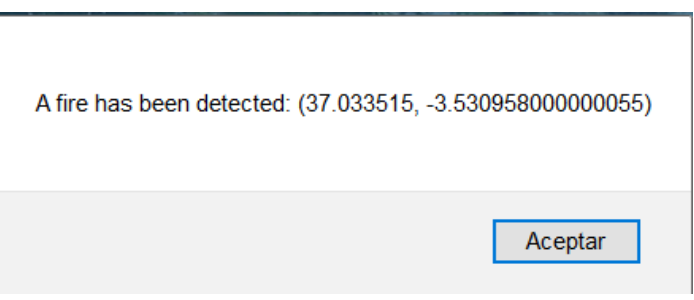
Figure 14. The Pop-up window when a fire is detected.